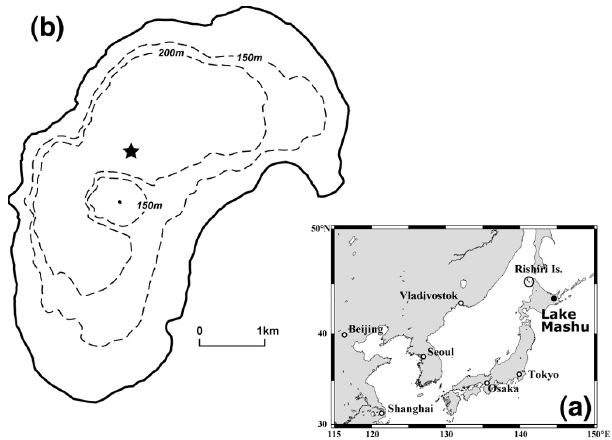
Fig. 1. Maps showing the location of Lake Mashu in East Asia (a) and the sampling station (asterisk) plotted on the bathymetry of Lake Mashu (b)